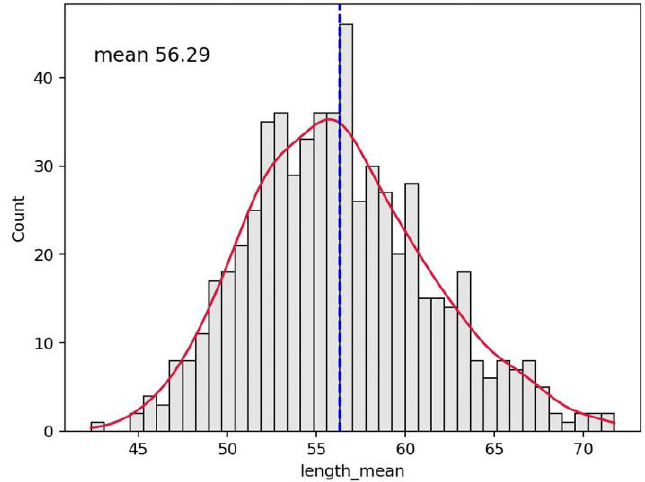
Figure 4. Histogram distribution of loop length for the whole video. As for Figure 2 the dashed line indicates the mean value (56.29 in this case); the red line interpolates the data for clearer reading.